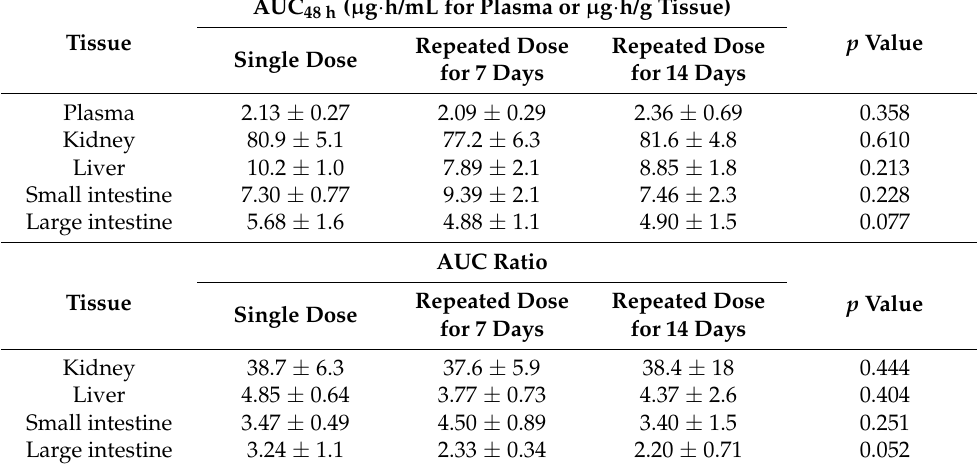
Figure 6. Plasma ( A ) and tissue concentration vs. time profiles of enavogliflozin in mice ( B ) kidney, ( C ) liver, ( D ) small intestine, and ( E ) large intestine following oral administrations of enavogliflozin (1 mg/kg) after a single dose ( • , single) or repeated dosing for 7days ( expressed as mean ± standard deviation (n = 7). Table 7. AUC values and AUC ratios of enavogliflozin in various tissues after single or repeated oral doses (1 mg/kg) of enavogliflozin in